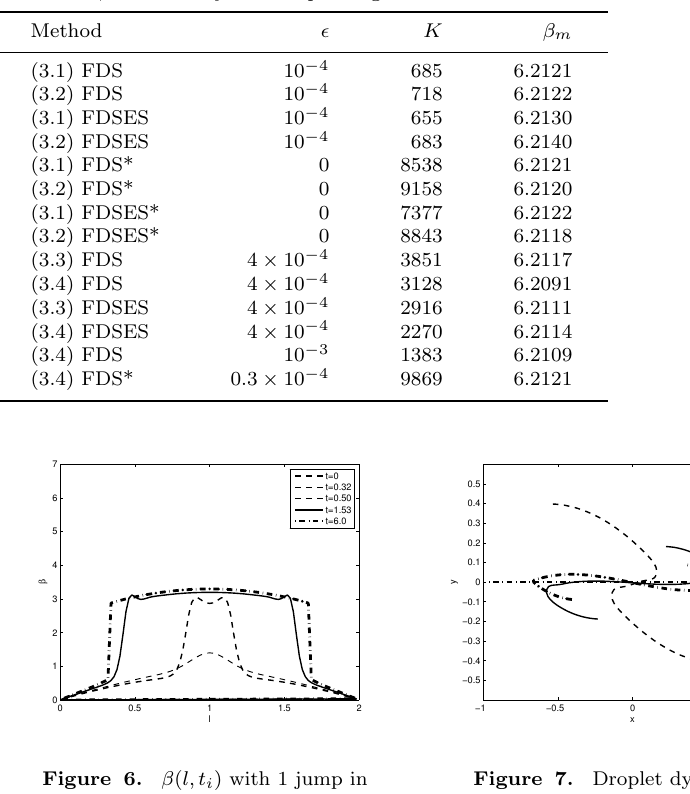
Table 1. β m and K by t = 6 depending on method and (cid:15) .